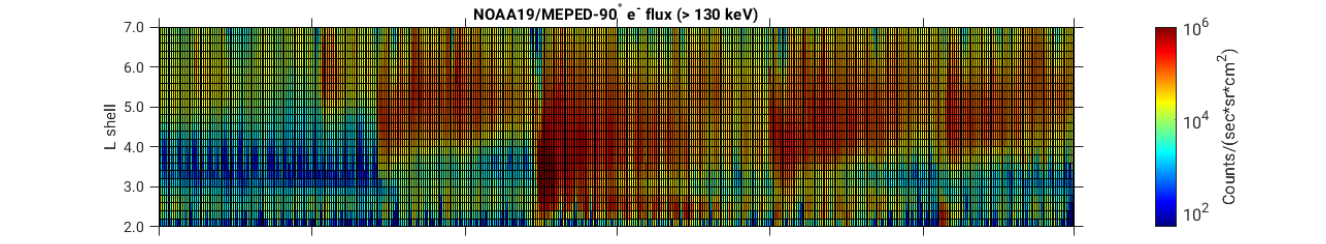
Figure 7. Integral electron fluxes ( > 130 keV) measured by the MEPED-90 ◦ directional telescope on board the NOAA19 satellite over the period Aug-Sept 2018. As reported in [35], proton contamination remains modest in this class of azimuthal detectors even at large L-shells in disturbed periods ( < 0.6% at 4 < L <